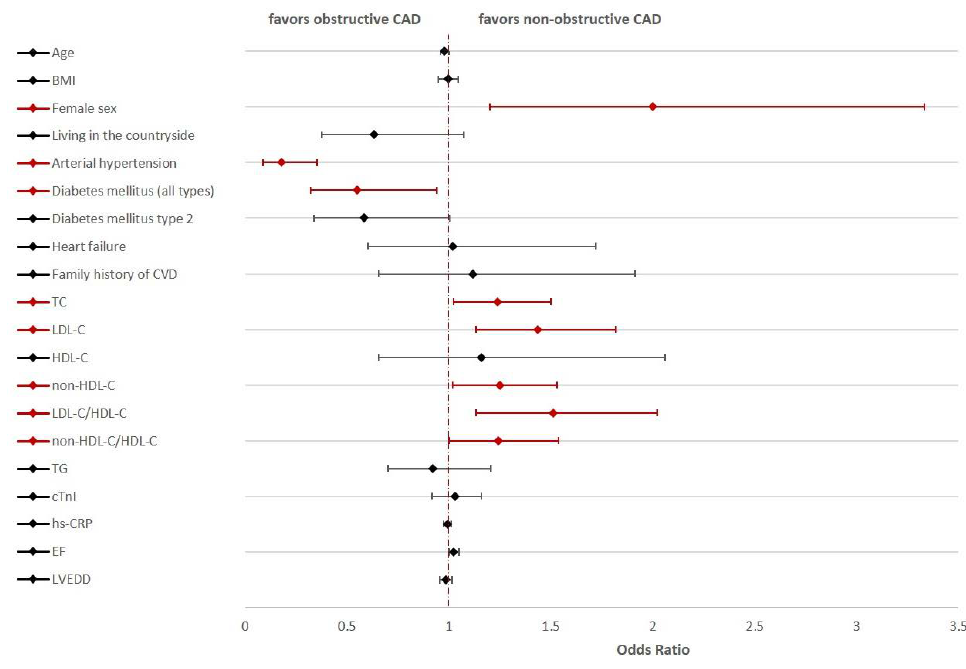
Figure 1. Univariable logistic regression